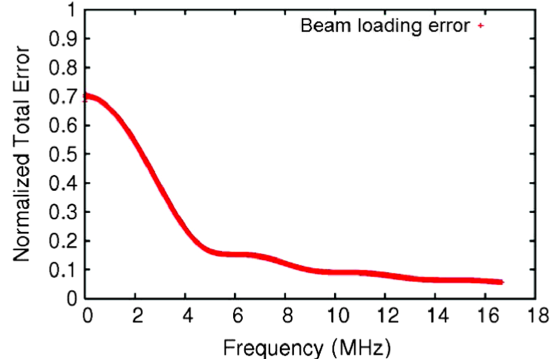
FIG. 4. Filtering factor of the ideal beam loading function vs bunch charge jitter